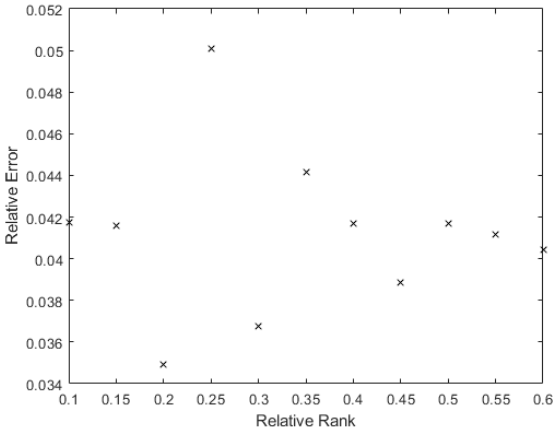
shows this for the X 2 layer.